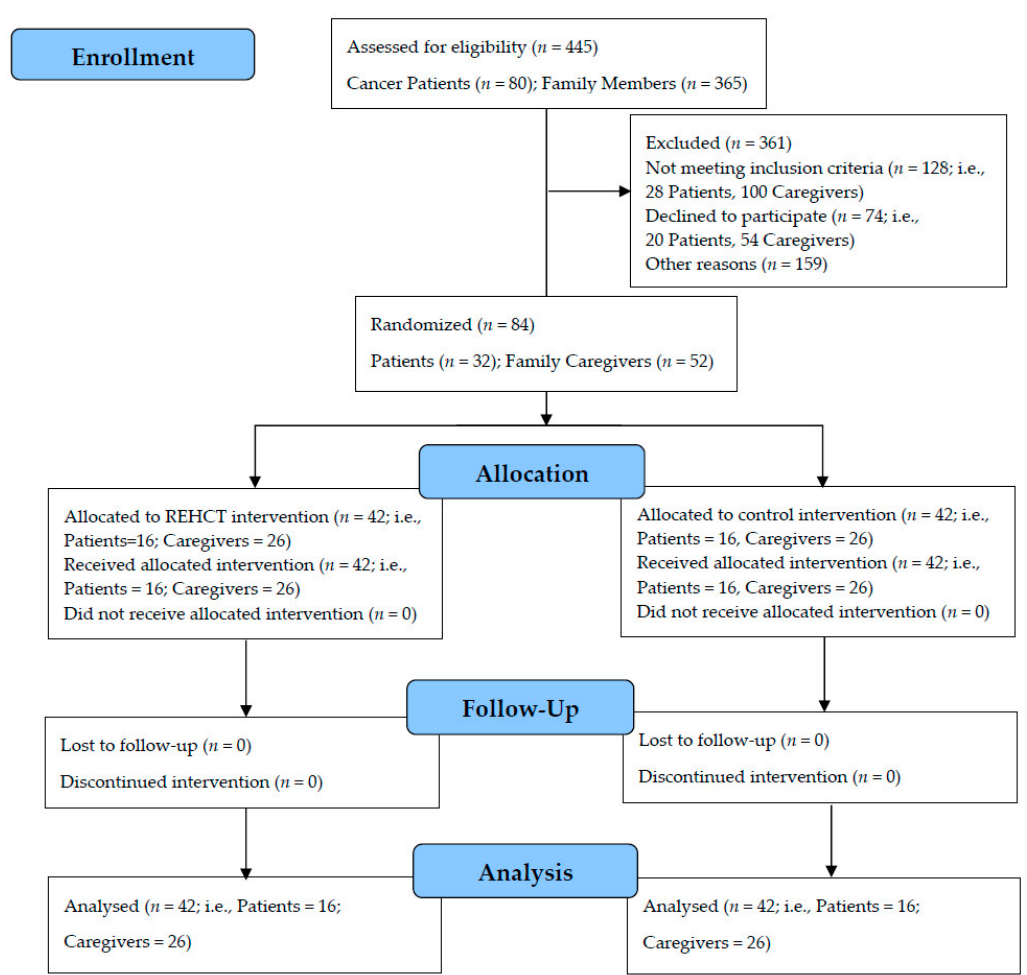
Figure 1. Flow diagram of the participant eligibility criteria.